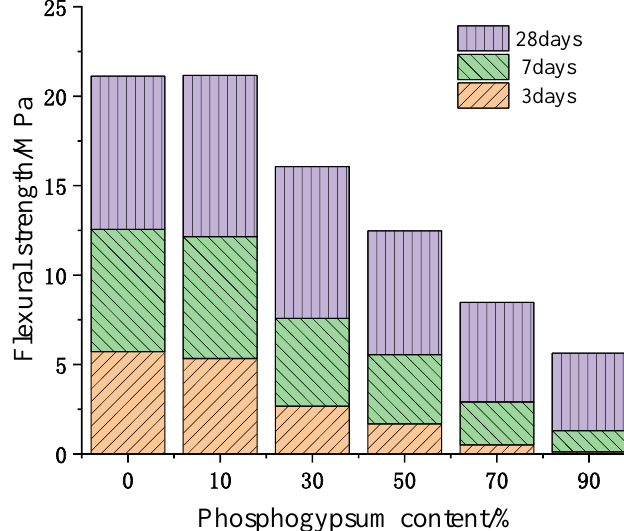
12 of 16 Figure 8. Microstructure of composite cementitious material at 28 days: ( a ) 0% phosphogypsum; ( b ) 10% phosphogypsum; ( c ) 30% phosphogypsum; ( d ) 50% phosphogypsum; ( e ) 70% phosphogyp- sum; ( f ) 90% phosphogypsum. 3.7. Mechanical Properties of Composite Cementitious Material Figure 9 shows the flexural strength of a composite cementitious material mortar containing 10% to 90% phosphogypsum after 3, 7, and 28 days. The changing trend of composite cementitious material flexural strength is presented, with the flexural strength increasing first and then decreasing with increasing phosphogypsum from 0% to 90%, indicating that the flexural strength reached its maximum value with the incorporation of 10% phosphogypsum among all mixtures. For example, at 28 days, the flexural strength